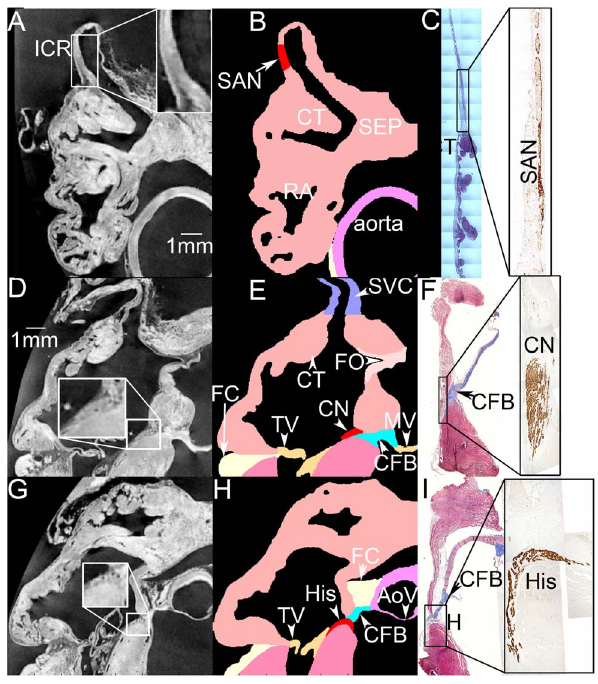
Figure 1. Identification of the SAN and AVN by comparing the MR images with Masson’s trichrome stained and neurofila- ment-immunolabelled sections from the intercaval region and triangle of Koch region. A, D and G, MR images including the intercaval region (A), the compact node (part of the AVN; D) and the His bundle (G). Nodal regions are enlarged (boxes). B, E and H, corresponding segmented model sections including the SAN (B) and AVN (E and H). Different segmented structures are shown in different colours. C, F and I, sections through the SAN (C) and AVN (F and I) stained with Masson’s trichrome and labelled for neurofilament (inset boxes). Masson’s trichrome stains myocytes red and connective tissue blue. The neurofilament-positive (brown) cells are nodal. AoV, aortic valve; CFB, central fibrous body; CN, compact AVN; CT, crista terminalis; FC, outer fatty and connective tissue; FO, fossa ovalis; His, His bundle; ICR, intercaval region; MV, mitral valve; RA, right atrium; RV, right ventricle; SEP, interatrial septum; SVC, superior vena cava; TV, tricuspid valve.